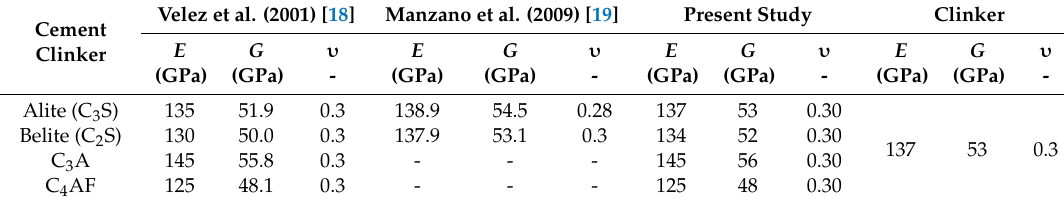
Table 2. Elastic properties of cement clinker constituents.